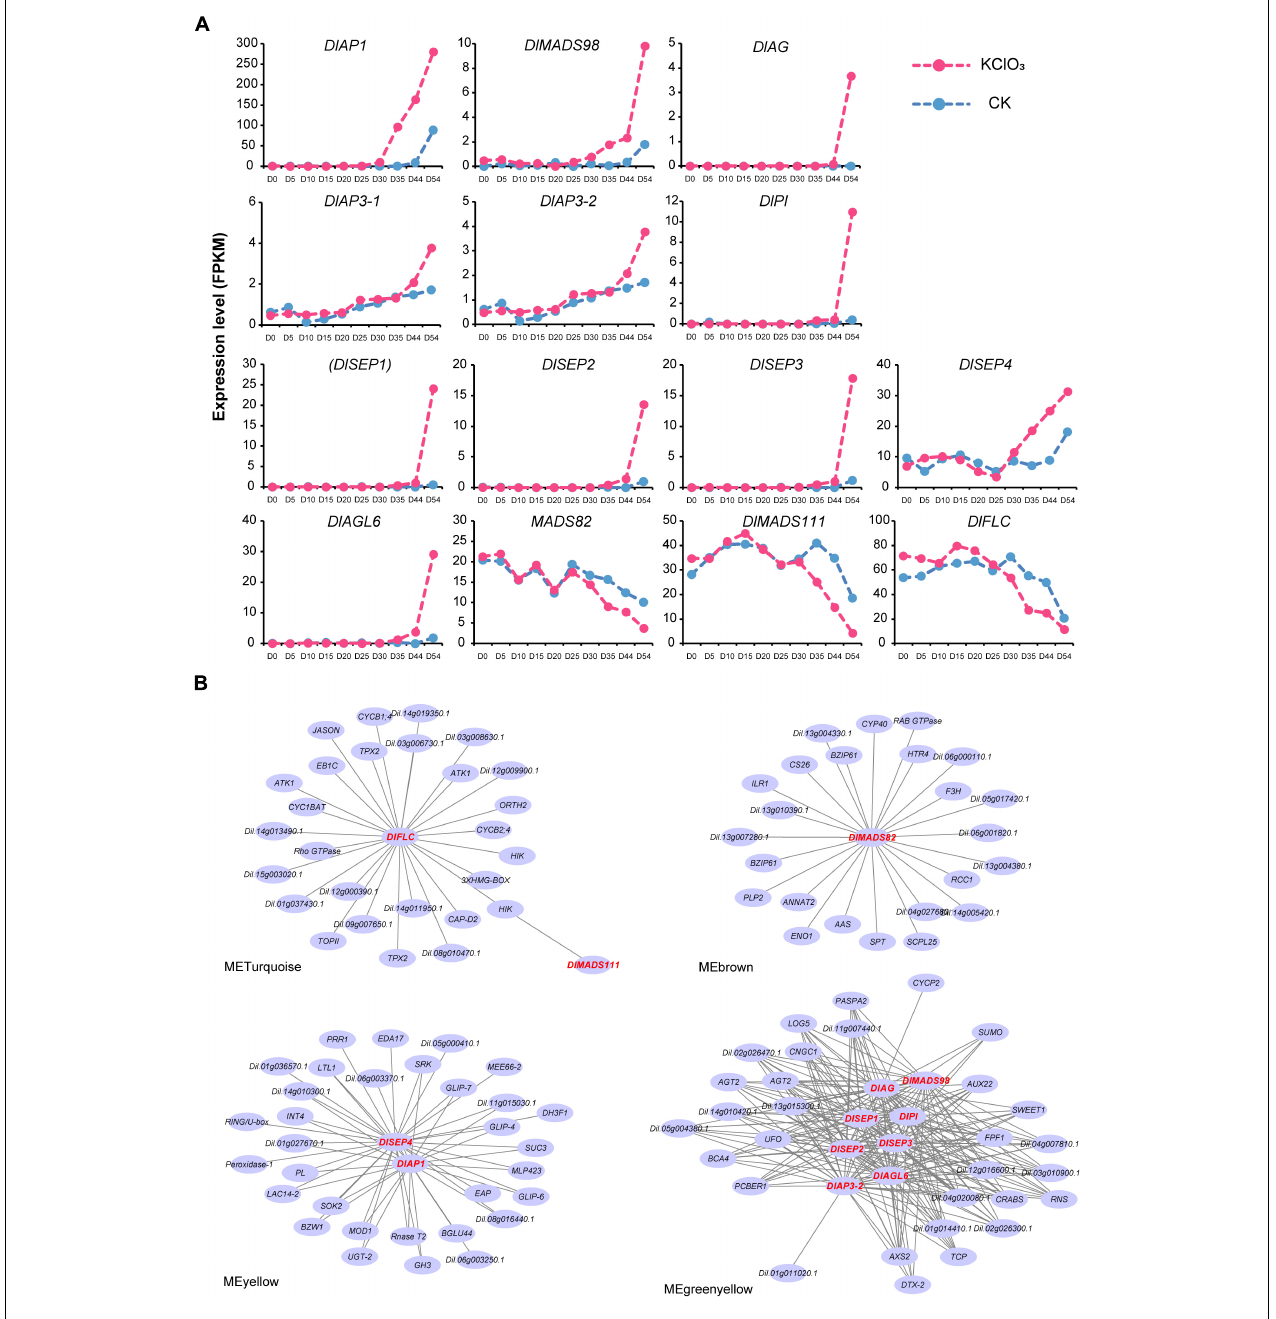
FIGURE 8 | Transcript analysis of longan MADS-box genes in off-season flower induction. (A) Expression profile of differentially expressed MADS-box genes during 10 stages (day 0 ∼ 54) under CK and KClO 3 treatment. (B) Co-expression networks of differential expression MADS-box genes during off-season flower induction. Each node represents a gene and the lines between nodes represent co-expression